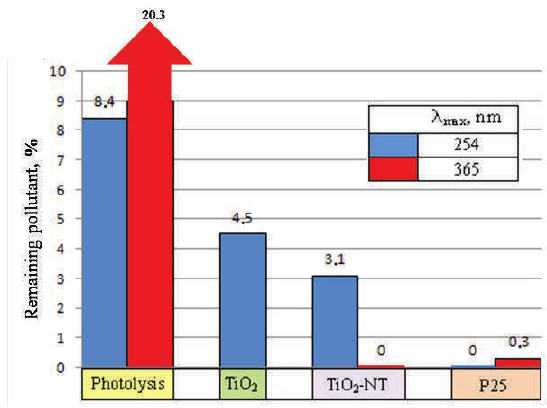
Figure 13. Remaining pollutant (%) after 60 min illumination with UV-light with λ =254 nm or λ =365 nm in presence max max of different